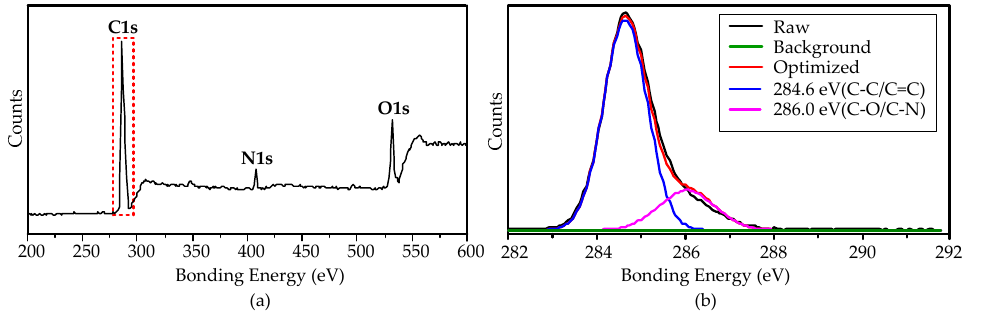
Figure 7. XPS spectra of the CNTs grown on the aluminum foils by the AMPCVD at 900 °C. ( a ): the global spectra; ( b ): the magnification view of C1s.